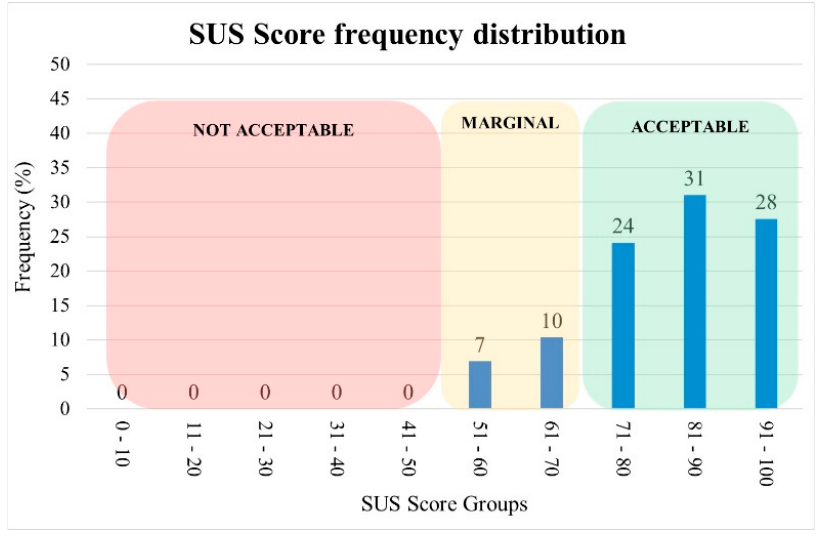
Figure 11. Change in total sickness measure of each stage.